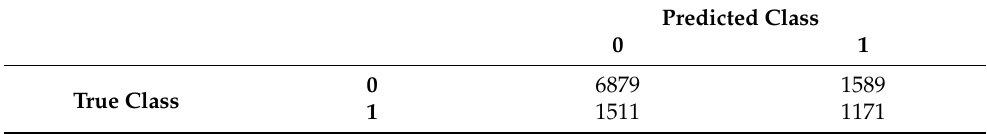
Table 11. Error matrix—Results with temperature.